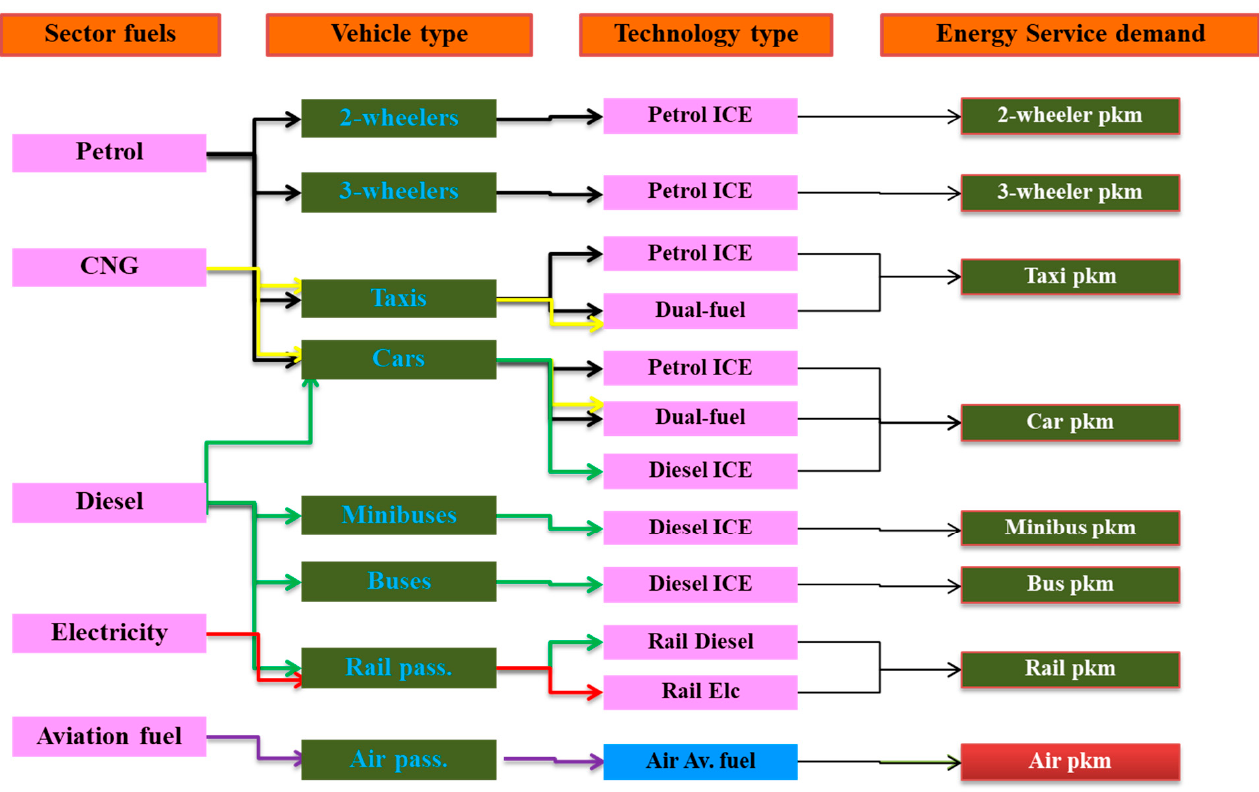
Figure 7. Energy flow across the transportation sector in Pakistan .